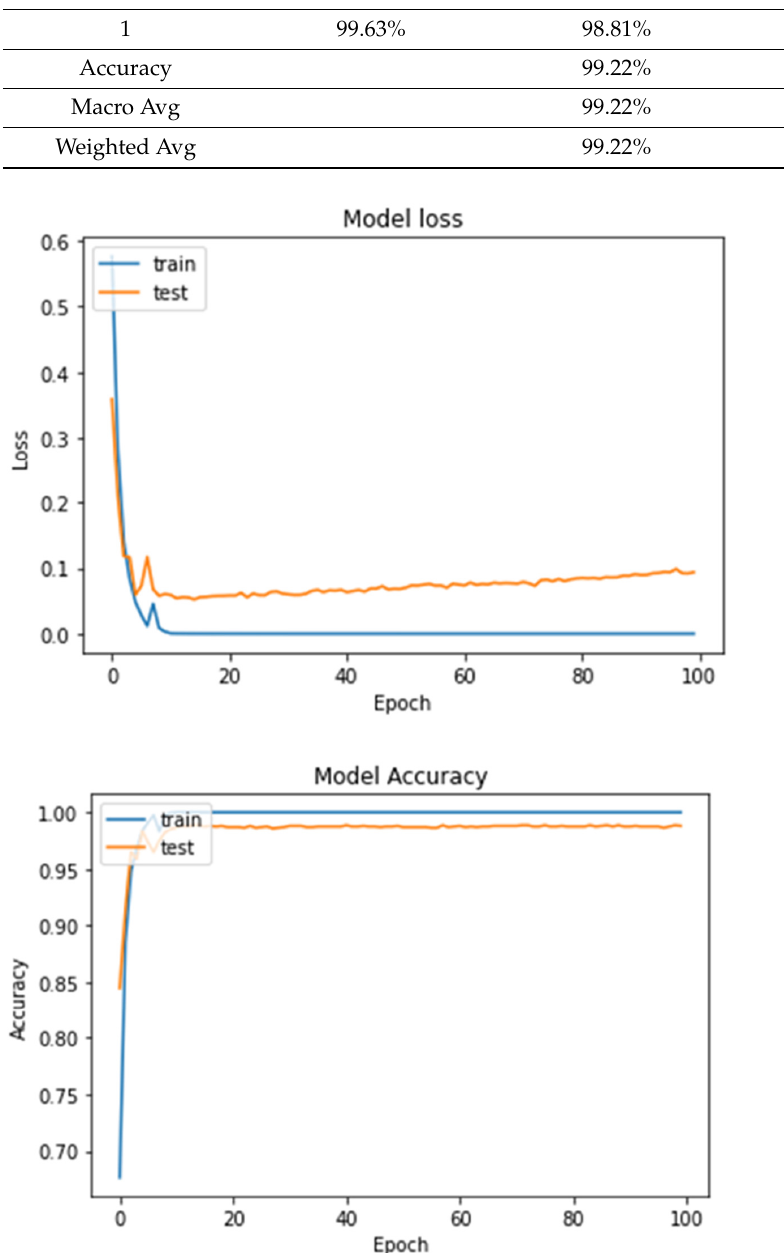
Figure 10. Loss curves ( upper ) and accuracy curves ( lower ) for the training and testing data for the proposed model for binary classification task .